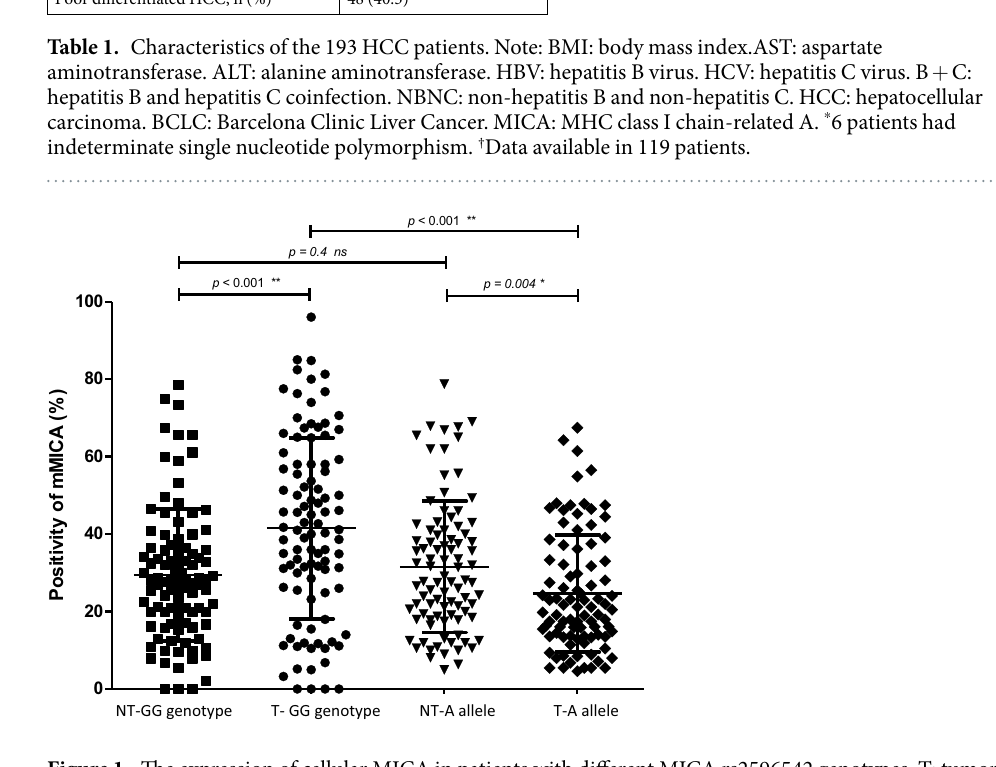
Figure 1. The expression of cellular MICA in patients with different MICA rs2596542 genotypes. T: tumor tissue. NT: non-tumor part of the tissue. A allele: MICA rs2596542 allele. GG genotype: MICA rs2596542 GG